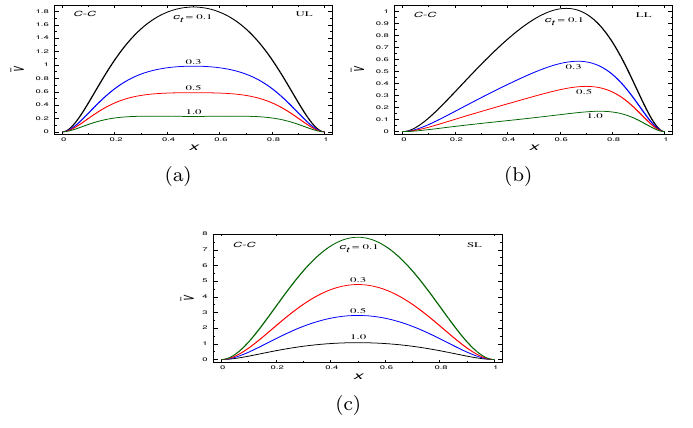
Figure 5. Effect of viscous damping parameter c t on the distribution of angular displacement along the axial direction of a C-C CNT subjected to: (a) UL, (b) LL, and (c)